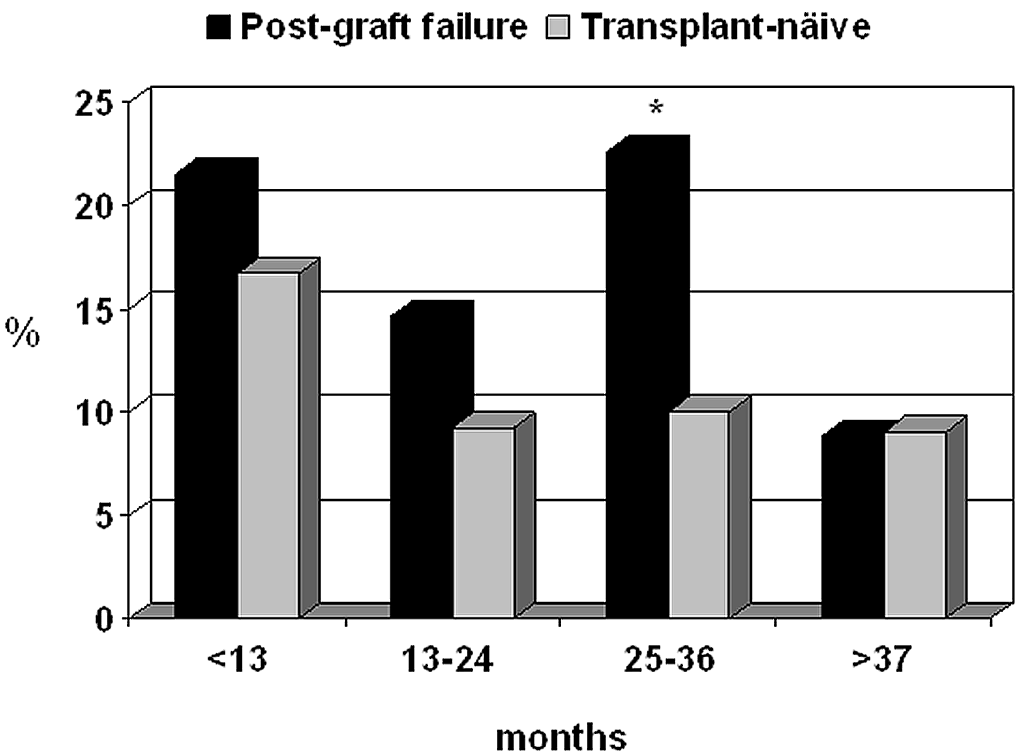
Fig 2. Proportion of deaths in both groups of waiting-list patients according to time on list. Overall comparison: chi- square = 42.8; P < 0.0001 (cid:3) P = 0.029 vs. transplant-na¨ive waitlisted patients (chi-square = 4.77).